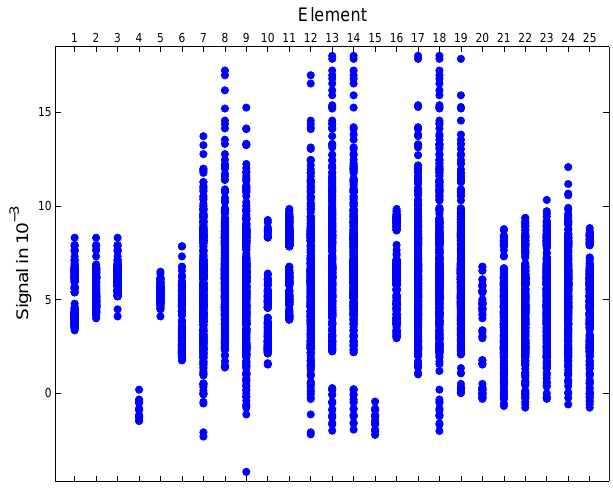
Fig. 11. Signal list for system 3 with multiplicative noise using time series of 10000yr. Ordinate: absolute signal; abscissa: elements of the system. Any area that has been calculated during the analysis is represented at the ordinate value of its signal. All elements that are part of this area are marked as blue dots. Parameter settings correspond to set 21 in Table